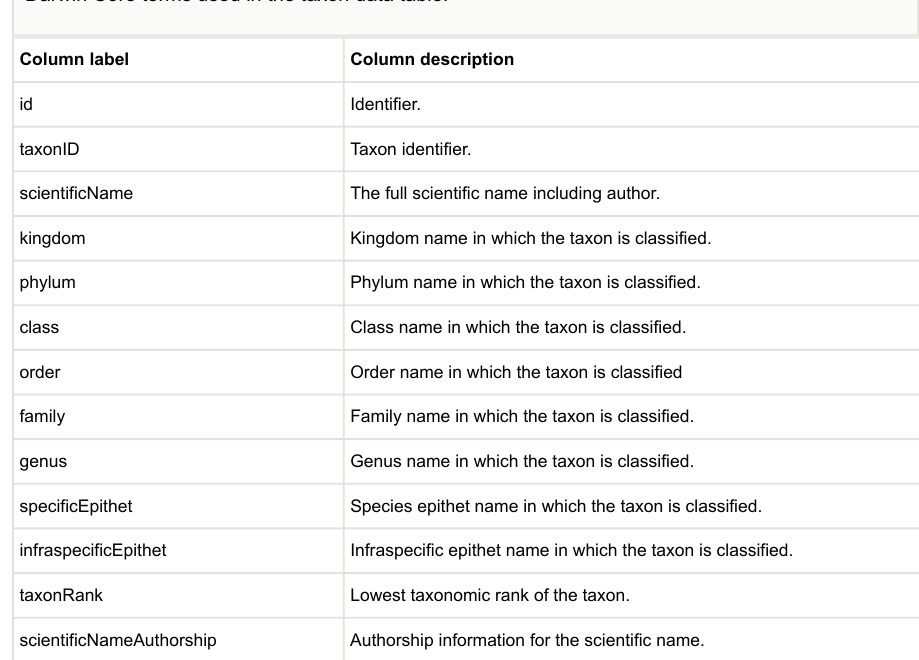
Darwin Core terms used in the taxon data